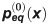
Results from fitting the 2011 NU empirical BMI distribution (black dots) to our predicted distributions peq(0)(x) (no social effects; red solid) and peq(x) (with social effects; red dashed), and to a standard log-normal (blue dash-dotted) distribution.From top to bottom, the first panel illustrates how the BMI distribution results from a balance between drift and diffusion, and is right-skewed. The second panel shows the same BMI distributions in log scale to make tails more visible, and the third panel shows differences between the log-normal distribution as null-model and the other distributions. The second and third panels show that the peq(0)(x) (red solid) and peq(x) (red dashed) distributions are more successful in fitting the empirical data than the commonly used log-normal distribution, both near the center of the distribution and in the high-BMI tail. This is confirmed in the bottom panel that shows the root mean-square error (RMSE) resulting from fitting NU data to BMI distributions in the range 1997–2014.